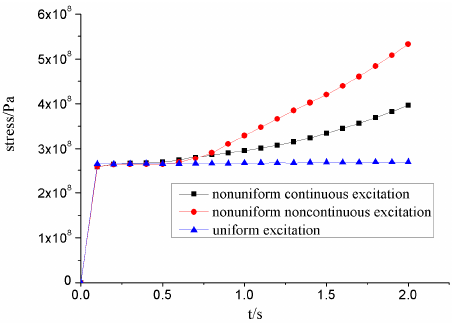
Figure 4. Comparison of the maximum stress point of the pipeline.